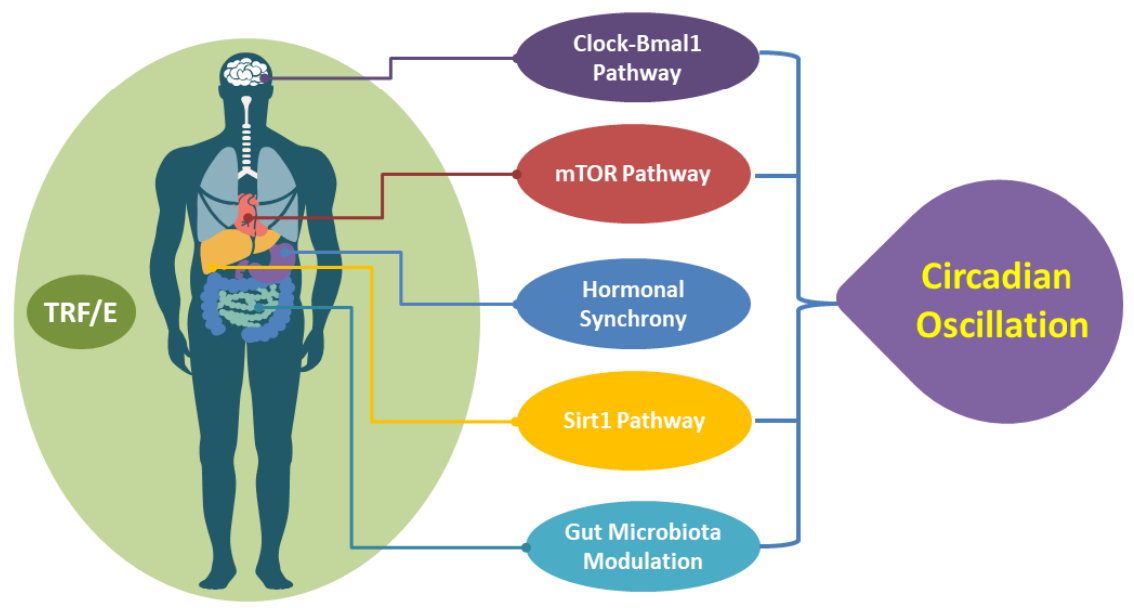
Figure 2. TRF/E-targeted pathways for the oscillation of the circadian rhythm